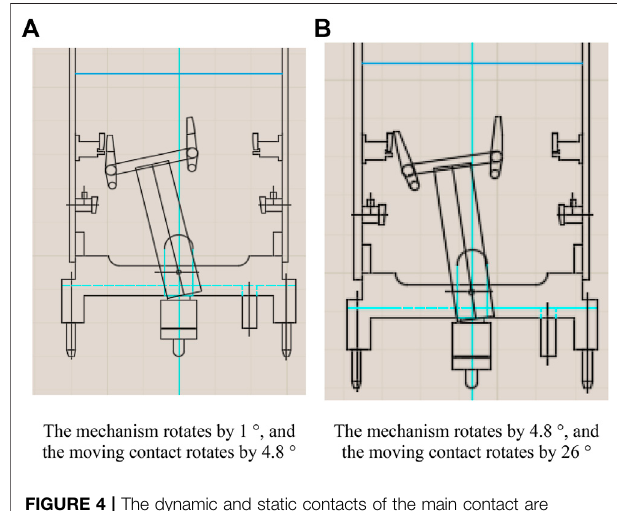
FIGURE 4 | The dynamic and static contacts of the main contact are from contact to separation. (A) The mechanism rotates by 1 ° , and the moving contact rotates by 4.8 ° . (B) The mechanism rotates by 4.8 ° , and the moving contact rotates by 26